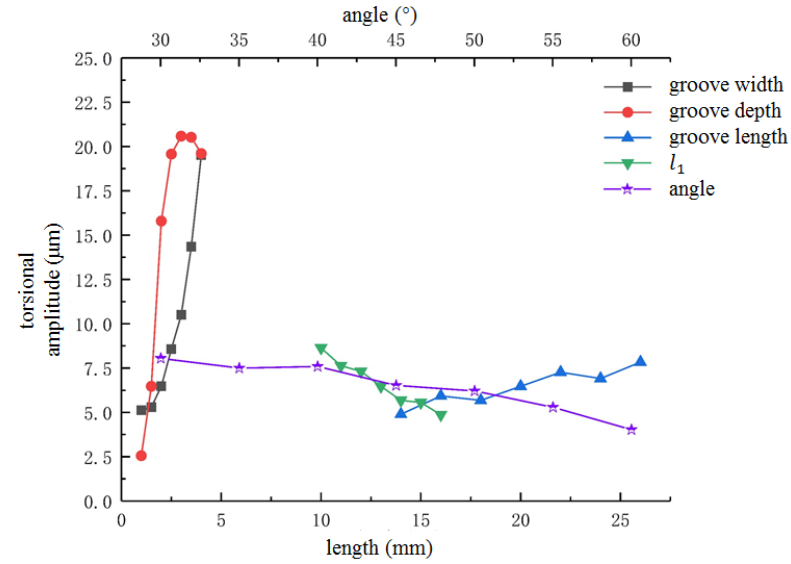
Figure 7. Effect of spiral groove parameters on torsional vibration.